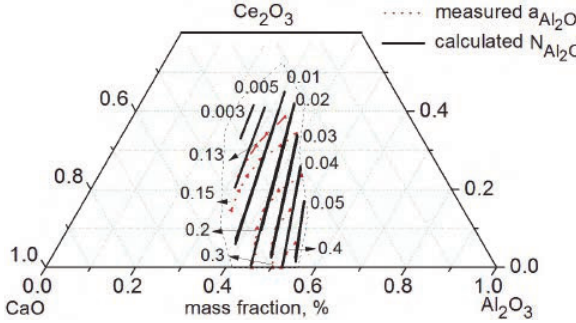
Fig. 2: The calculated iso-mass action concentration curves of Al 2 O 3 and measured iso-activity curves of Al slag system at 1773